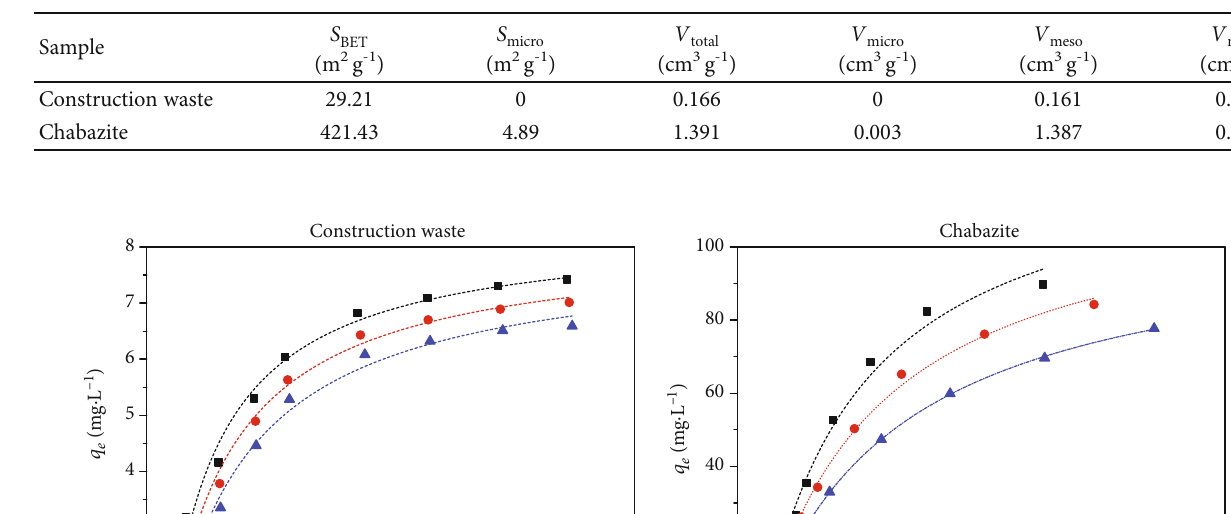
Table 2: Pore structure of construction waste and synthesized chabazite.